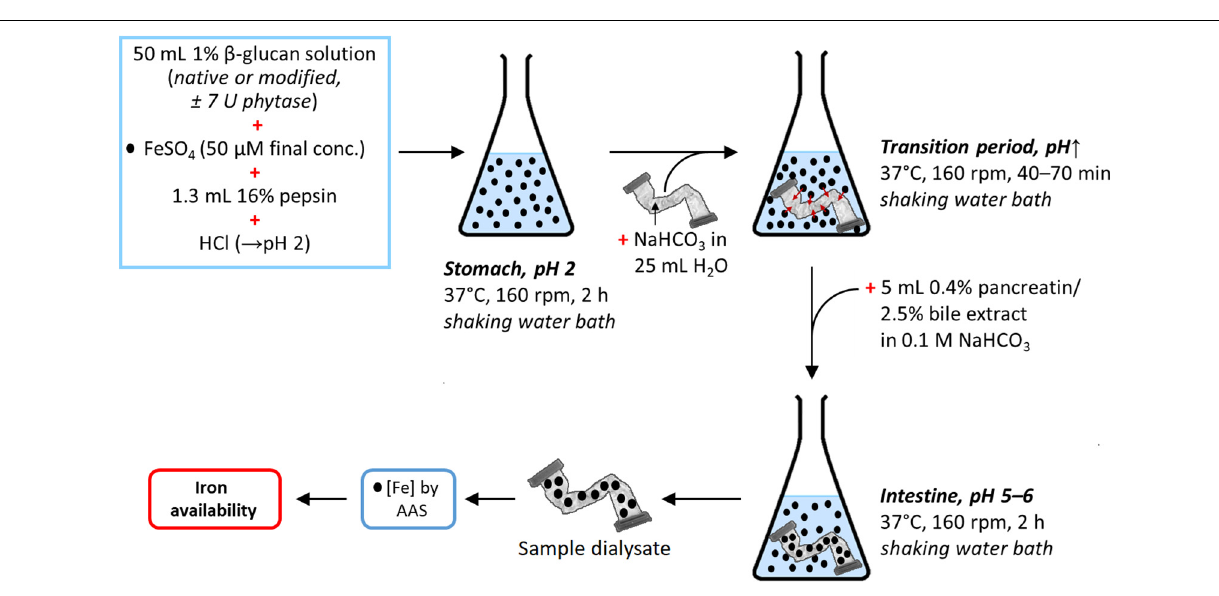
FIGURE 4 | Schematic representation of the in vitro digestion simulation to determine the dialysability (and hence estimate availability) of iron in the presence or absence of native or modified β -glucan extracts, with or without prior phytase treatment. The references ( ± phytase) in this experiment were obtained analogously, but with 50 mL water instead of 1% β -glucan solution. The same is the case for the blanks ( ± phytase), where 50 mL water was used as in the references, but without added iron ( • , Fe; see Figure 1 for a summary of all samples, references, and